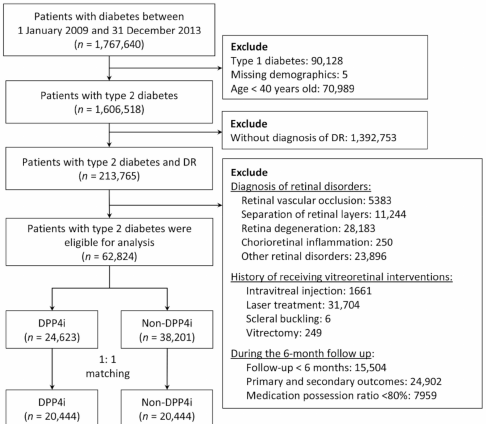
Figure 1. Flowchart of the inclusion and exclusion criteria of the patients. DR, diabetes retinopathy; DPP4i, dipeptidyl peptidase 4